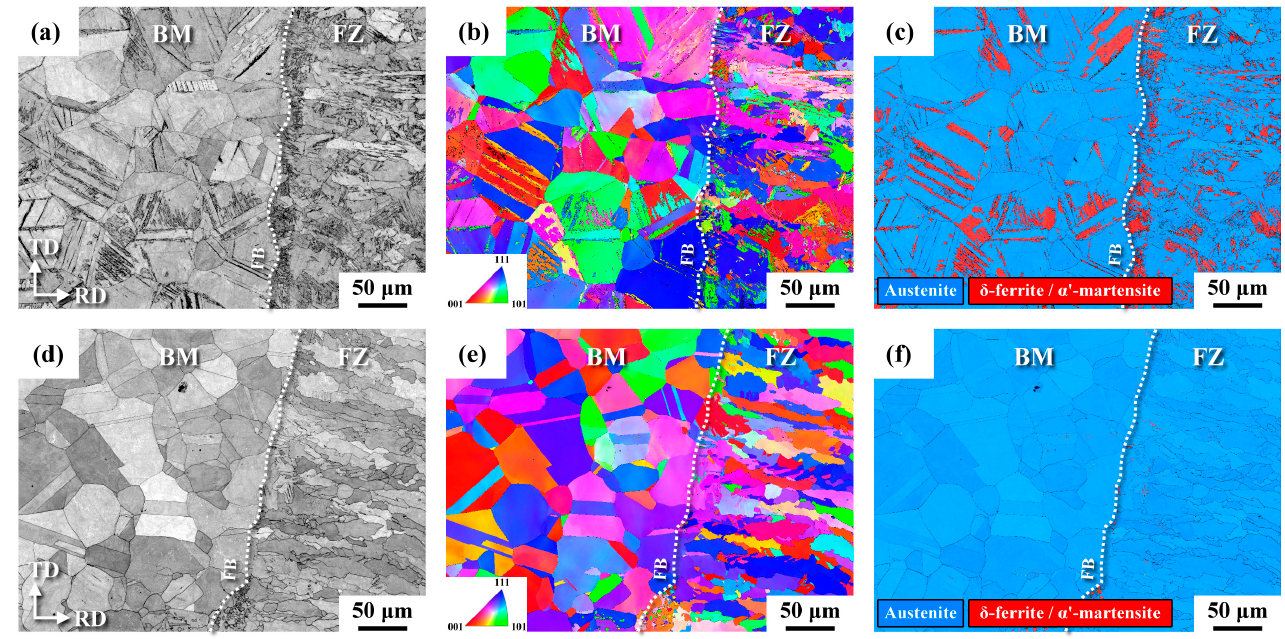
Figure 6. EBSD: ( a , d ) BC maps, ( b , e ) IPF maps, ( c , f ) phase maps of the U-bend samples around the FB in top view. ( a – c ) the 304 weld; ( d – f ) the 316 weld.